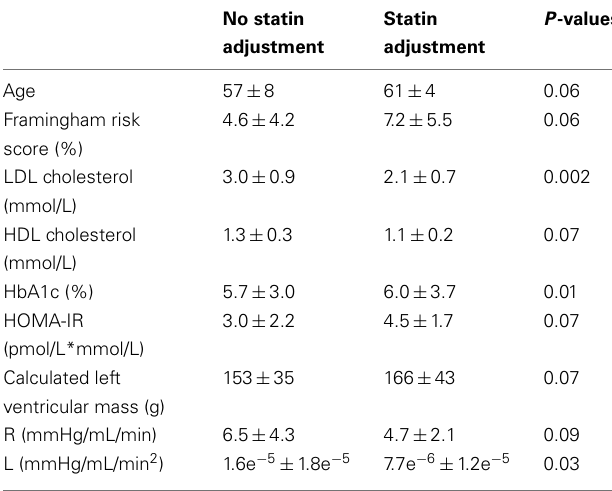
Table 5 | Effects of cholesterol medication